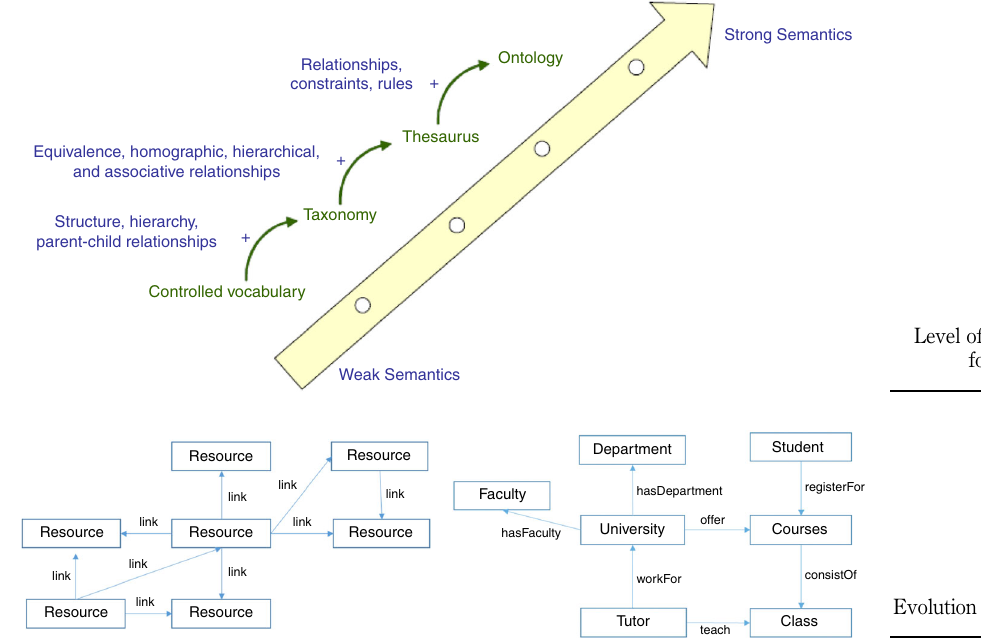
Figure 2. Evolution of the